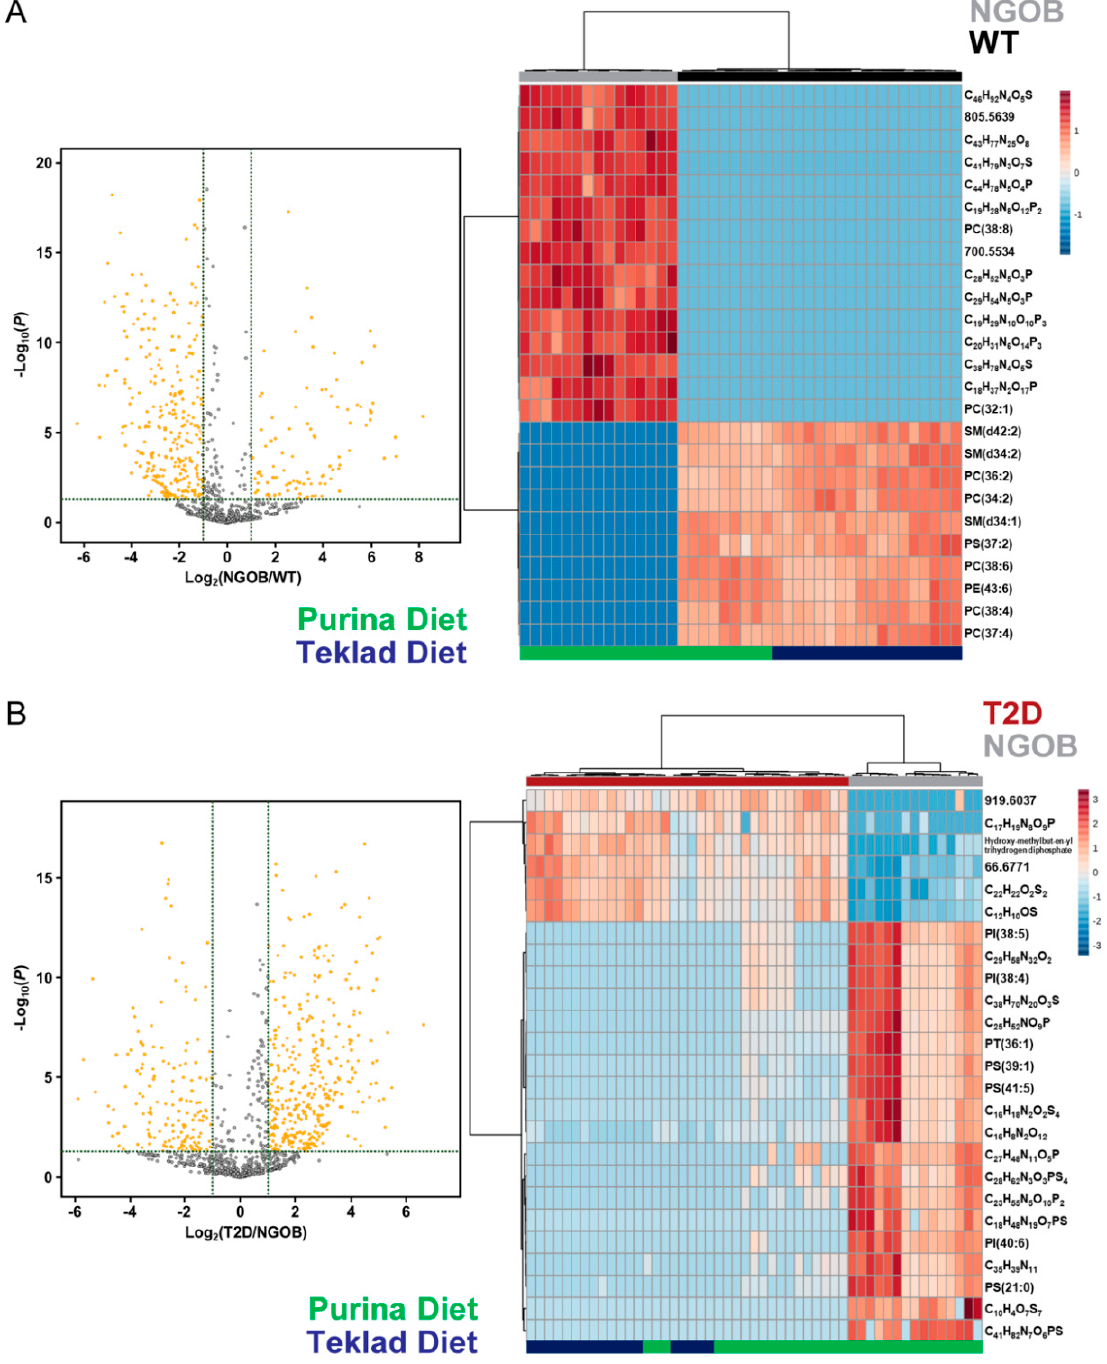
Figure 6. Volcano plots used to determine significantly differentially expressed annotated metabolic features (left) and heat maps created by unsupervised hierarchical clustering using the top 25 most highly differentially expressed of these (right) in pairwise comparisons of ( A ) NGOB vs. WT plasma samples and ( B ) T2D vs. NGOB plasma samples.